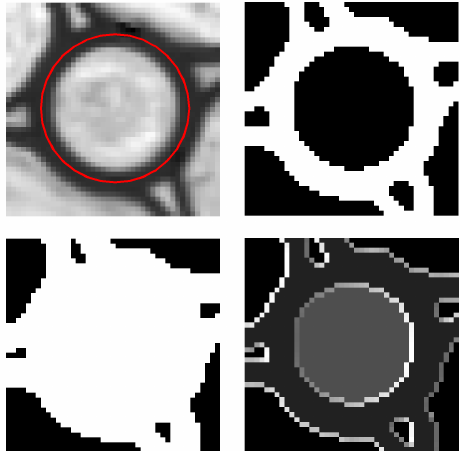
Figure 3. Illustration of the template generation. The roundabout in the optical image and the red marked circle inside the street (top left), the detected street (top right), the roundabout mask (bottom left) and the roundabout template (bottom